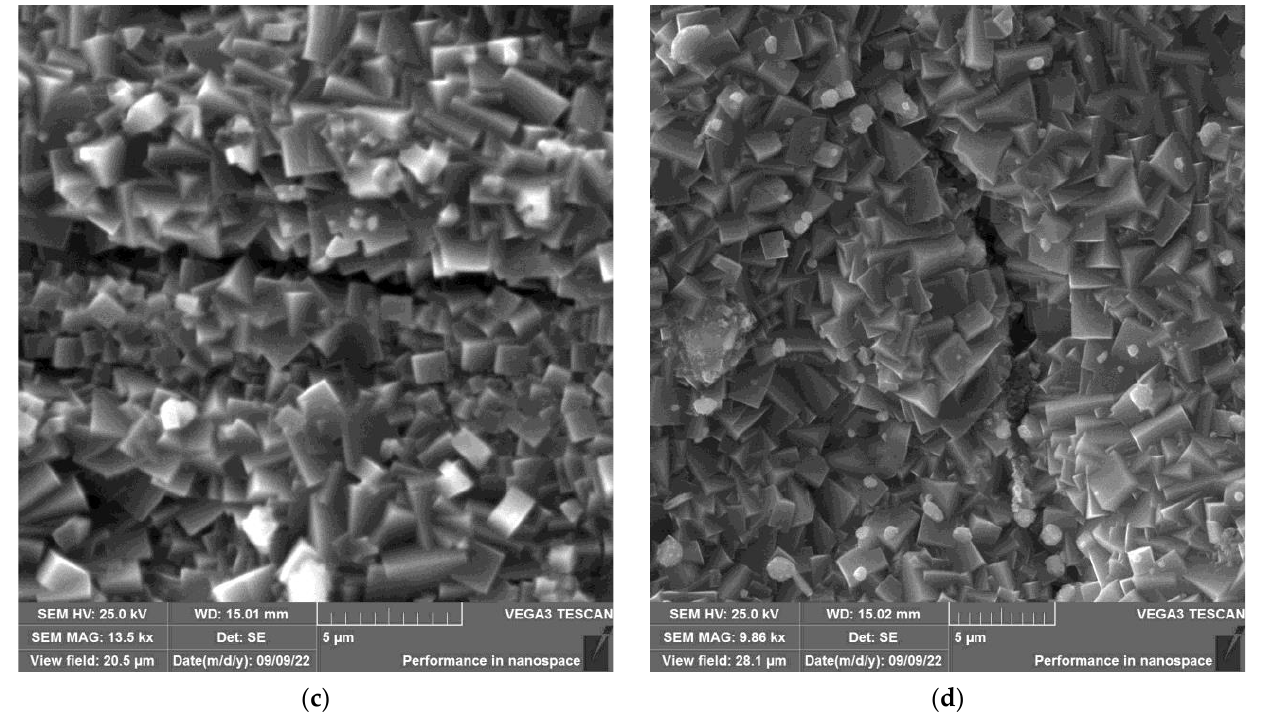
Figure 7. Surface of disk specimen № 1 (T irr = 390 °C, Table 4) at different magnifications after autoclave SCC tests with a load value of 801 N (before crack opening loading).